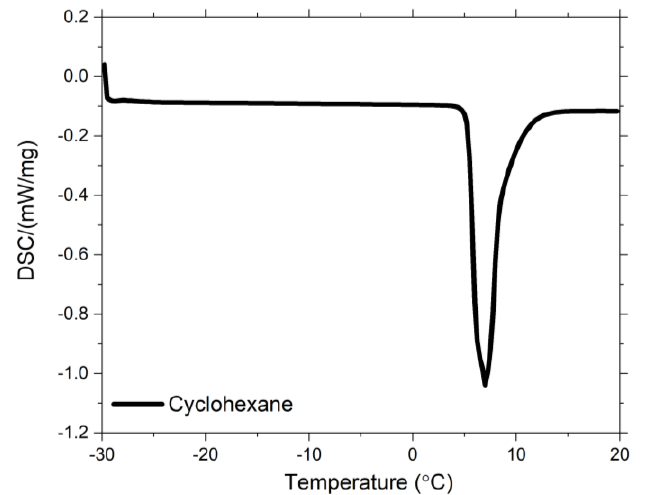
Figure 1. DSC freezing curve for pure